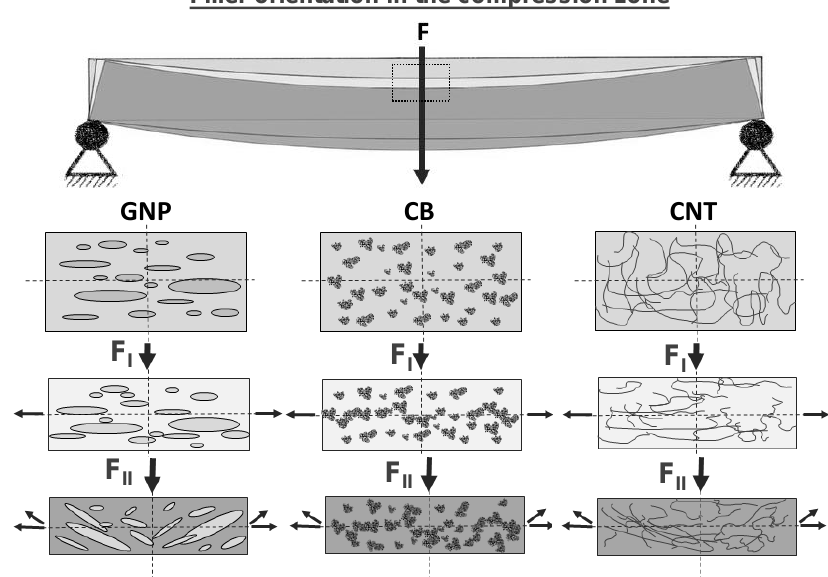
Figure 9. Orientation effects of different carbon allotropes on the nanostructured sensor fiber interphase during three-point bending test in the compression zone; exemplary shown for three different strain states.